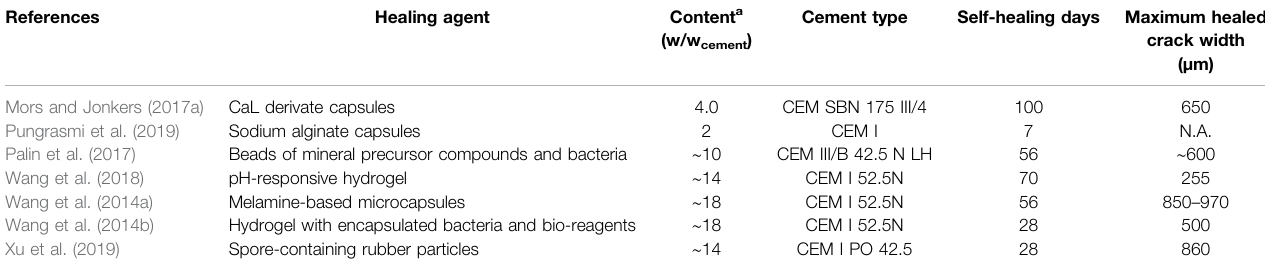
TABLE 1 | Overview of performance from previous studies conducted on bacteria-based self-healing concrete with encapsulated healing agents.